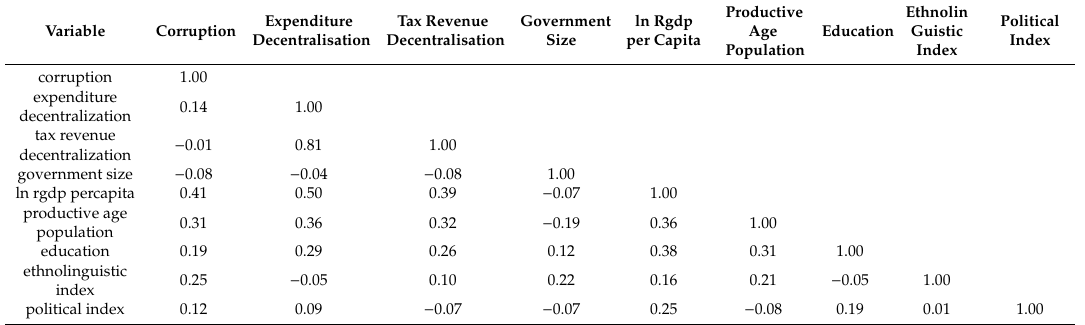
Table 2. Simple Correlation